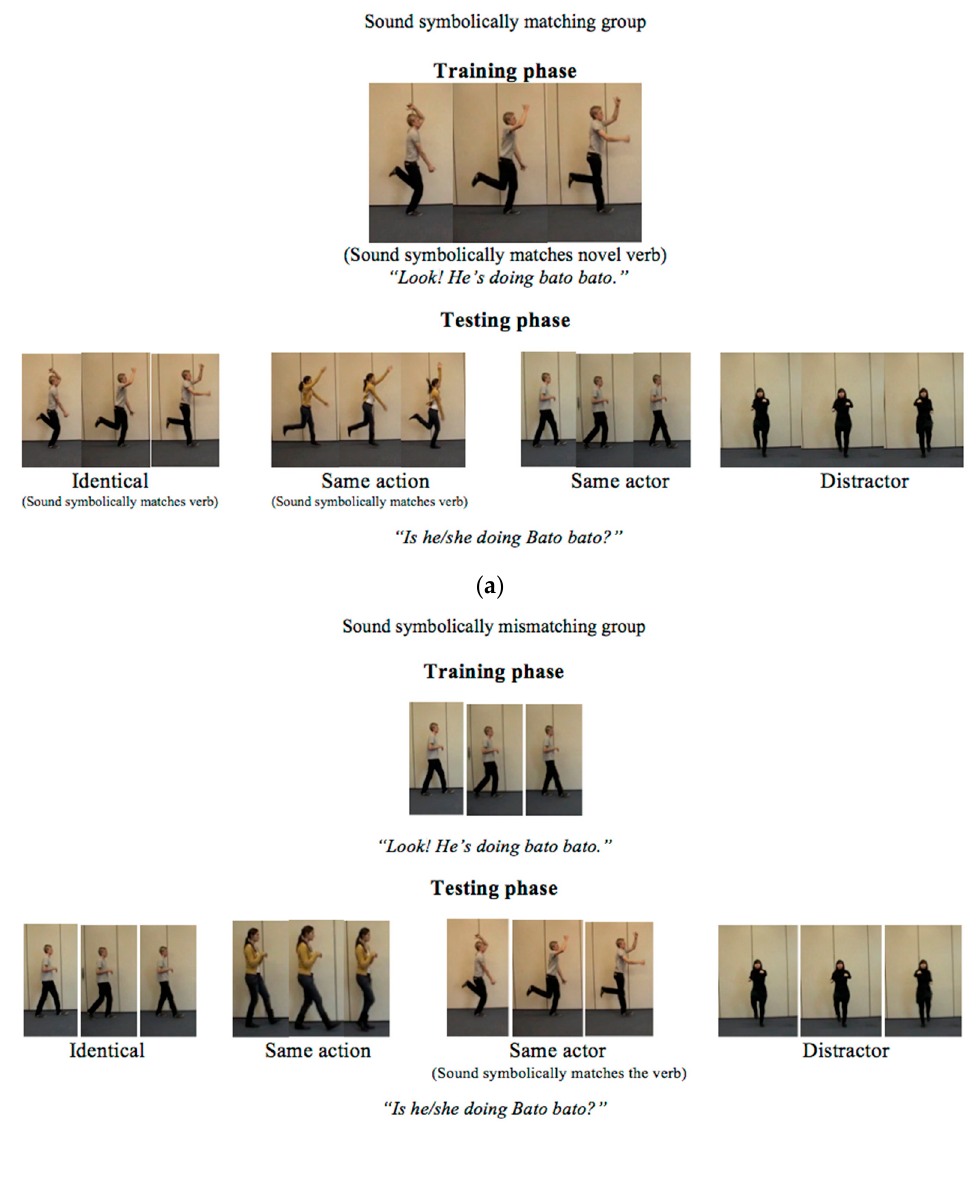
Figure 1. Examples of the videos children were shown for the novel word “bato bato” in the training and testing sessions ( a ) in the sound-symbolically matching condition, and ( b ) in the sound- symbolically mismatching condition. The correct responses would be “yes” for the Identical and Same action items, and “no” for the Same Actor and Distractor items. Table 1. Description of the matching and mismatching actions for each sound-symbolic